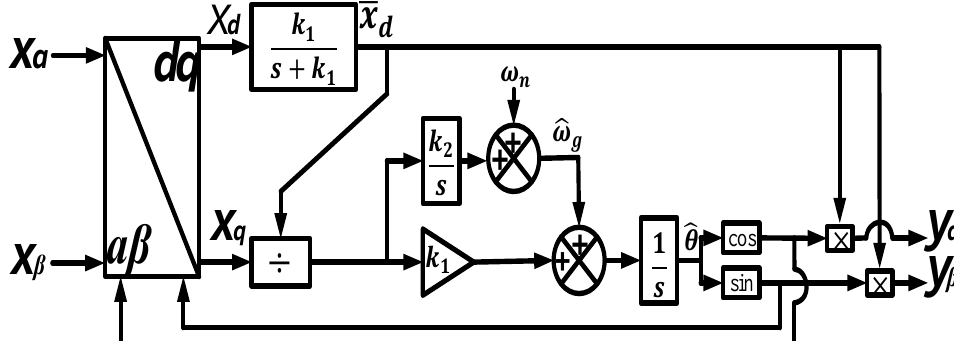
Figure 9. Conventional synchronous reference frame PLL [84].